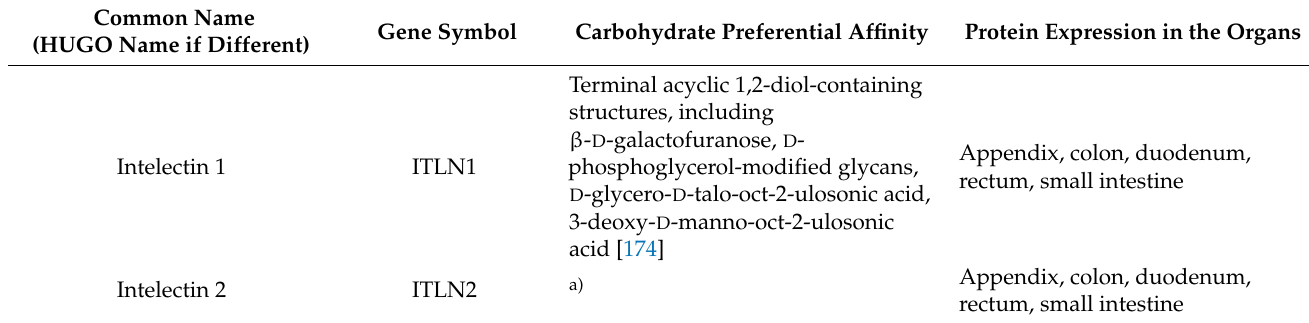
Table 12. Human X-type lectins, their carbohydrate ligands and protein expression in the